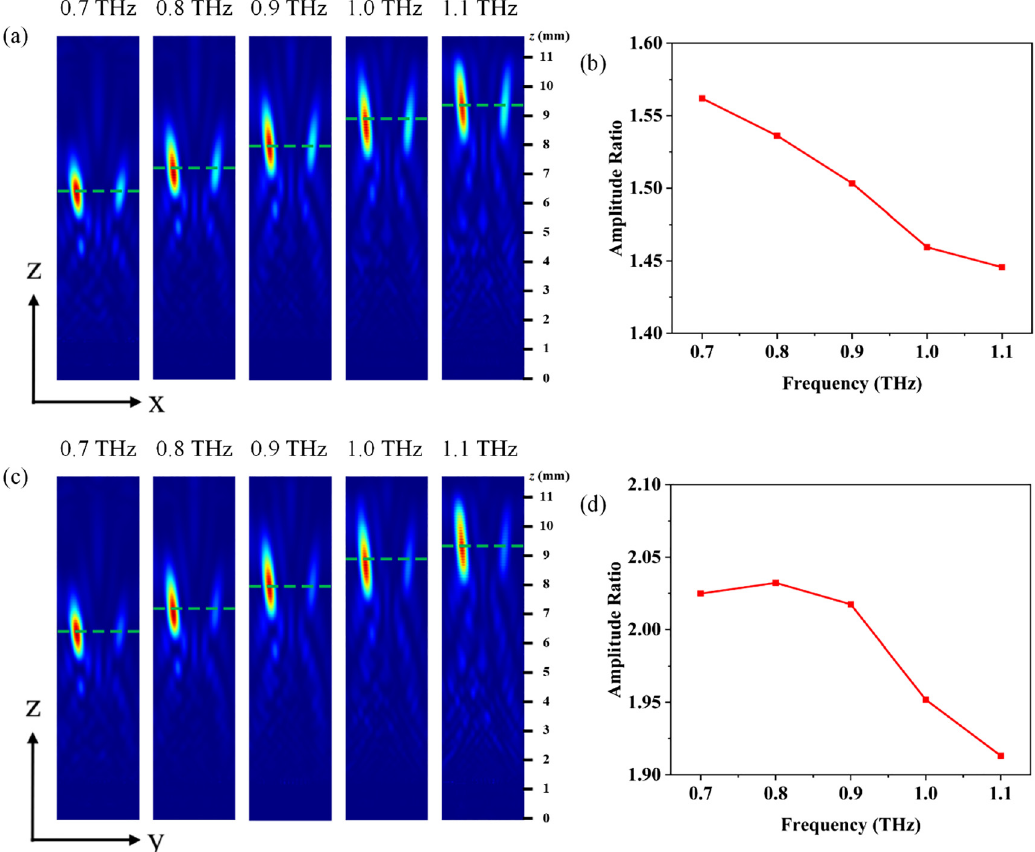
Figure 5: Characterization of broadband property of metalens. (a) The axial intensity profiles ( xoz ) under the LCP illumination with different frequencies. (b) The amplitude ratios of the generated two foci along the x axis under the different incident frequencies. (c) The axial intensity pro fi les ( yoz ) under the RCP illumination with different frequencies. (d) The amplitude ratios of the generated two foci along the y axis under the different incident